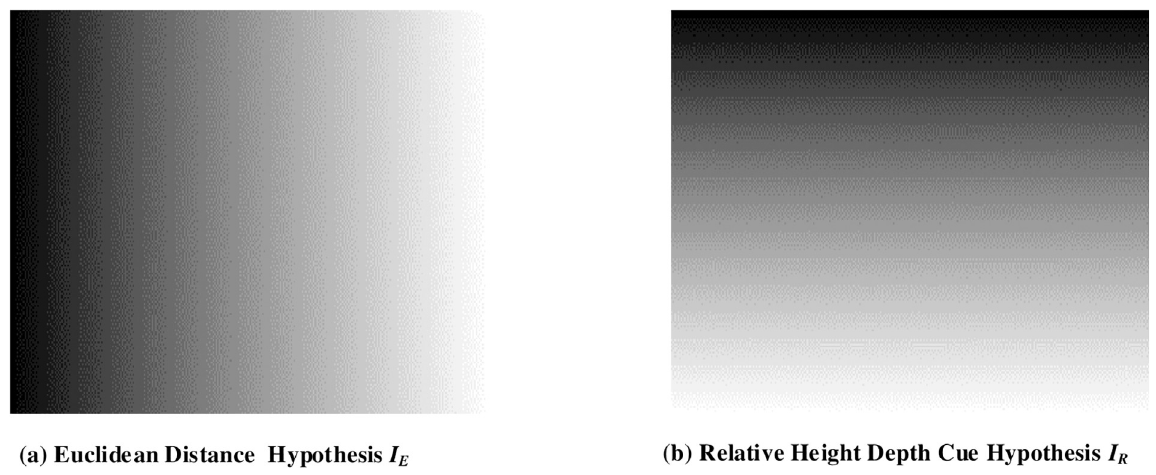
Fig 7. Image profile/depth hypothesis determination.